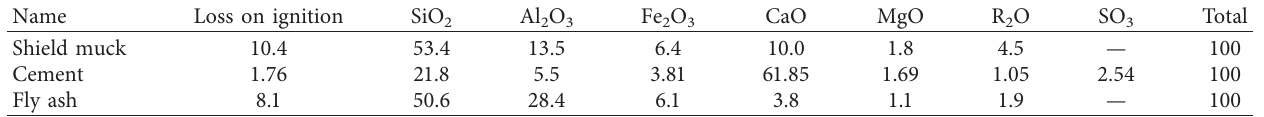
Table 1: Chemical composition of main raw materials (%).